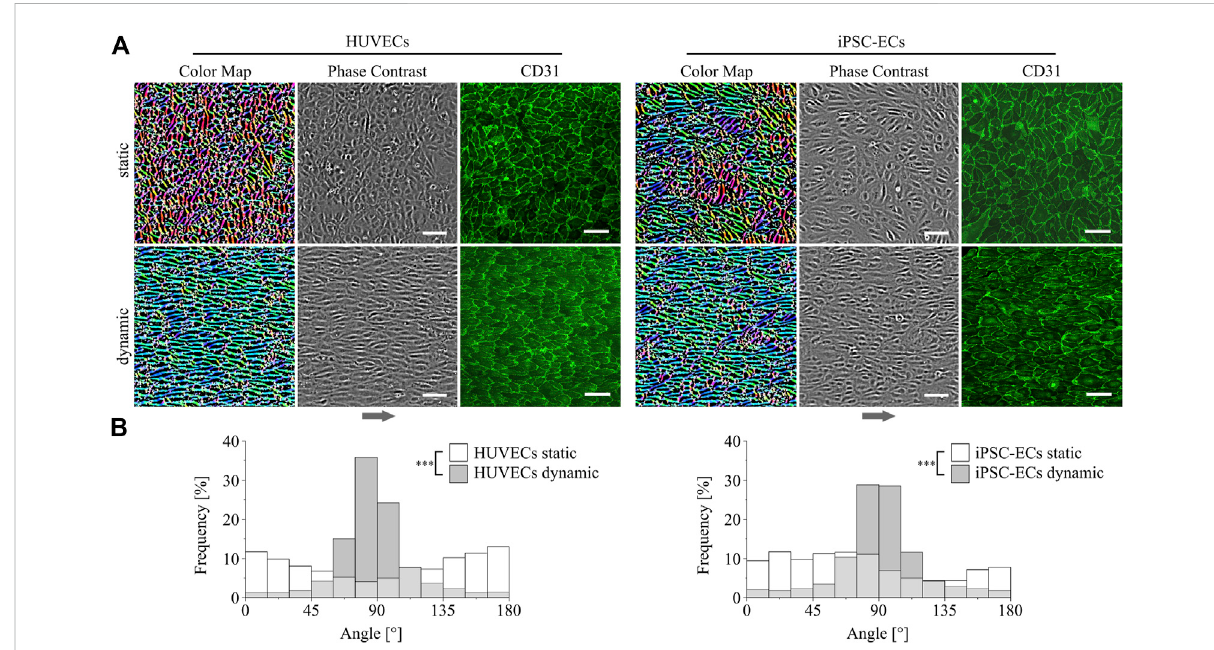
FIGURE 2 Directionality and differentiation analysis of HUVECs and iPSC-ECs on PGE-coated PS after culture with or without fl ow. (A) Qualitative cellular alignment after static and dynamic culture of HUVECs and iPSC-ECs (96 h), shown by phase contrast and corresponding color-coded images indicating cellular orientation by uniformity of coloration. Differentiation status was con fi rmed by confocal imaging of CD31 (green) as endothelial marker (independent sample) (Arrow indicates fl ow direction. Scale bars: 100 µm). (B) Quantitative orientation analyses determined from bright fi eldimagesafterstaticanddynamiccultureofHUVECsandiPSC-ECs(96 h)shownashistograms.Signi fi cantdifferenceswerefoundbetween each dynamic and the respective static condition for both cell types, respectively ( n = 3, Mann-Whitney Test, *** p <